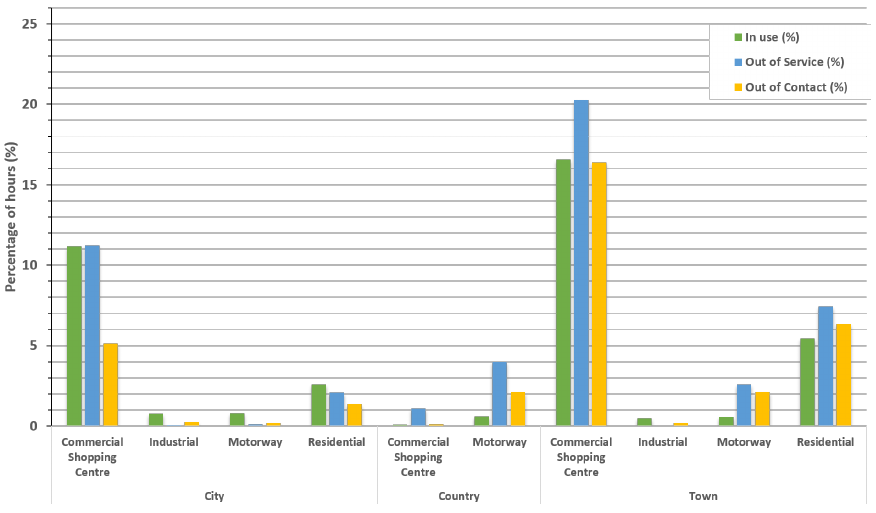
Figure 7. Total percentage of usage hours during monitored period for Standard Charging (Standard Type 2)